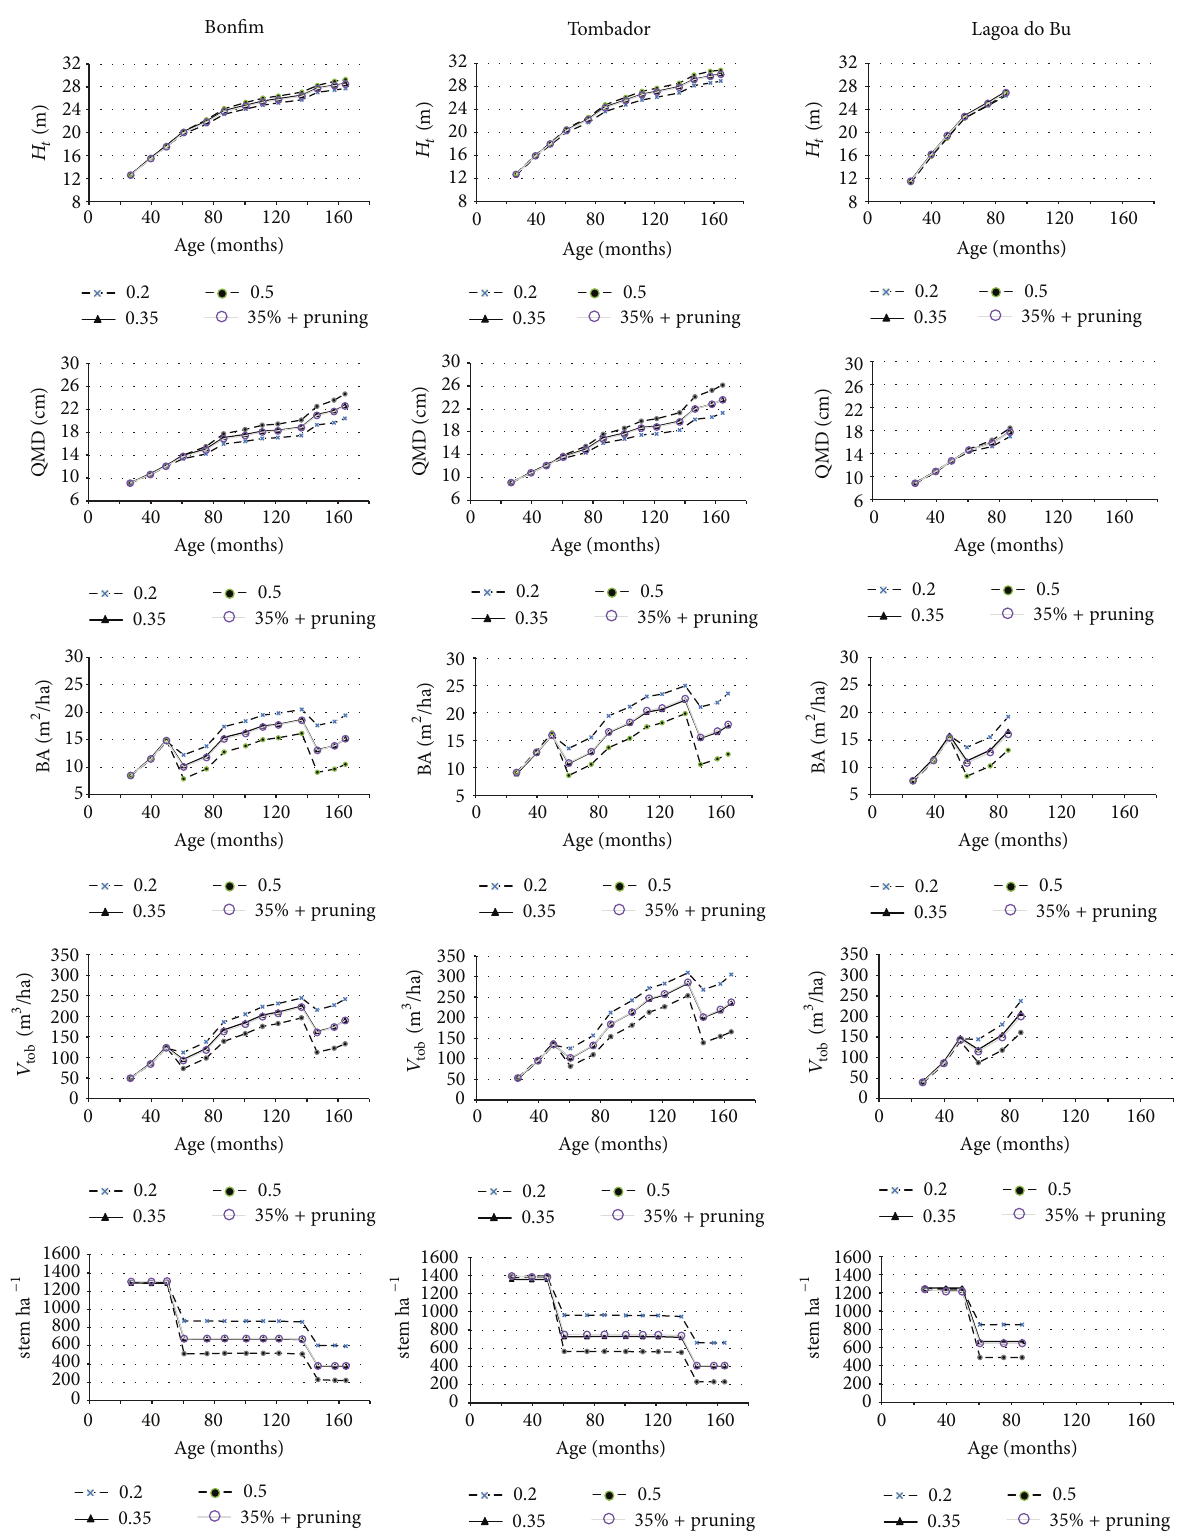
Figure2:Averageheight( 𝐻 𝑡 ),quadraticmeandiameter(QMD),basalareaperhectare(BA ha −1 ),volumeperhectareoutsidebark( 𝑉 and stems per hectare (stemsha −1 ) by installation, treatment, and stand